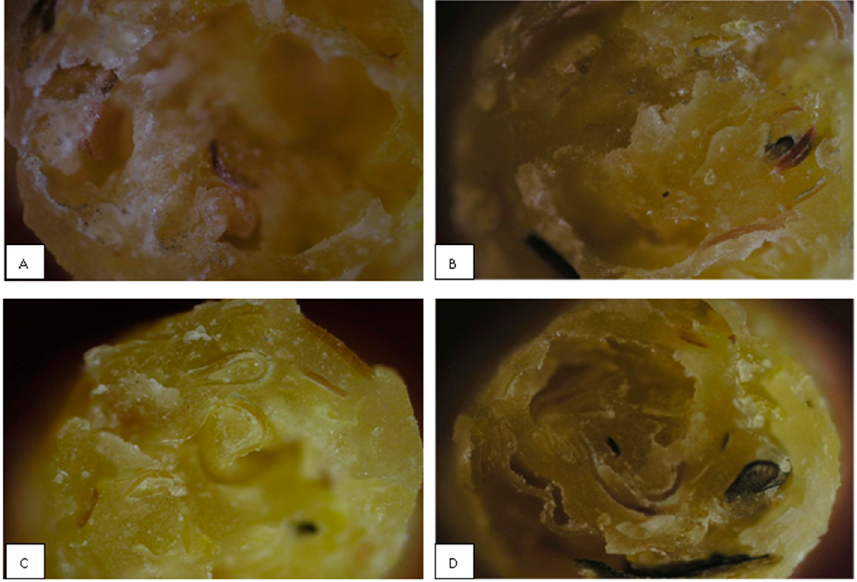
Figure 11. Microscopic pictures of extruded corn bran processed at 70 rpm extruder screw speed and at: ( A ) 20% moisture level, ( B ) 25% moisture level, ( C ) 30% moisture level and ( D ) 35% moisture level.